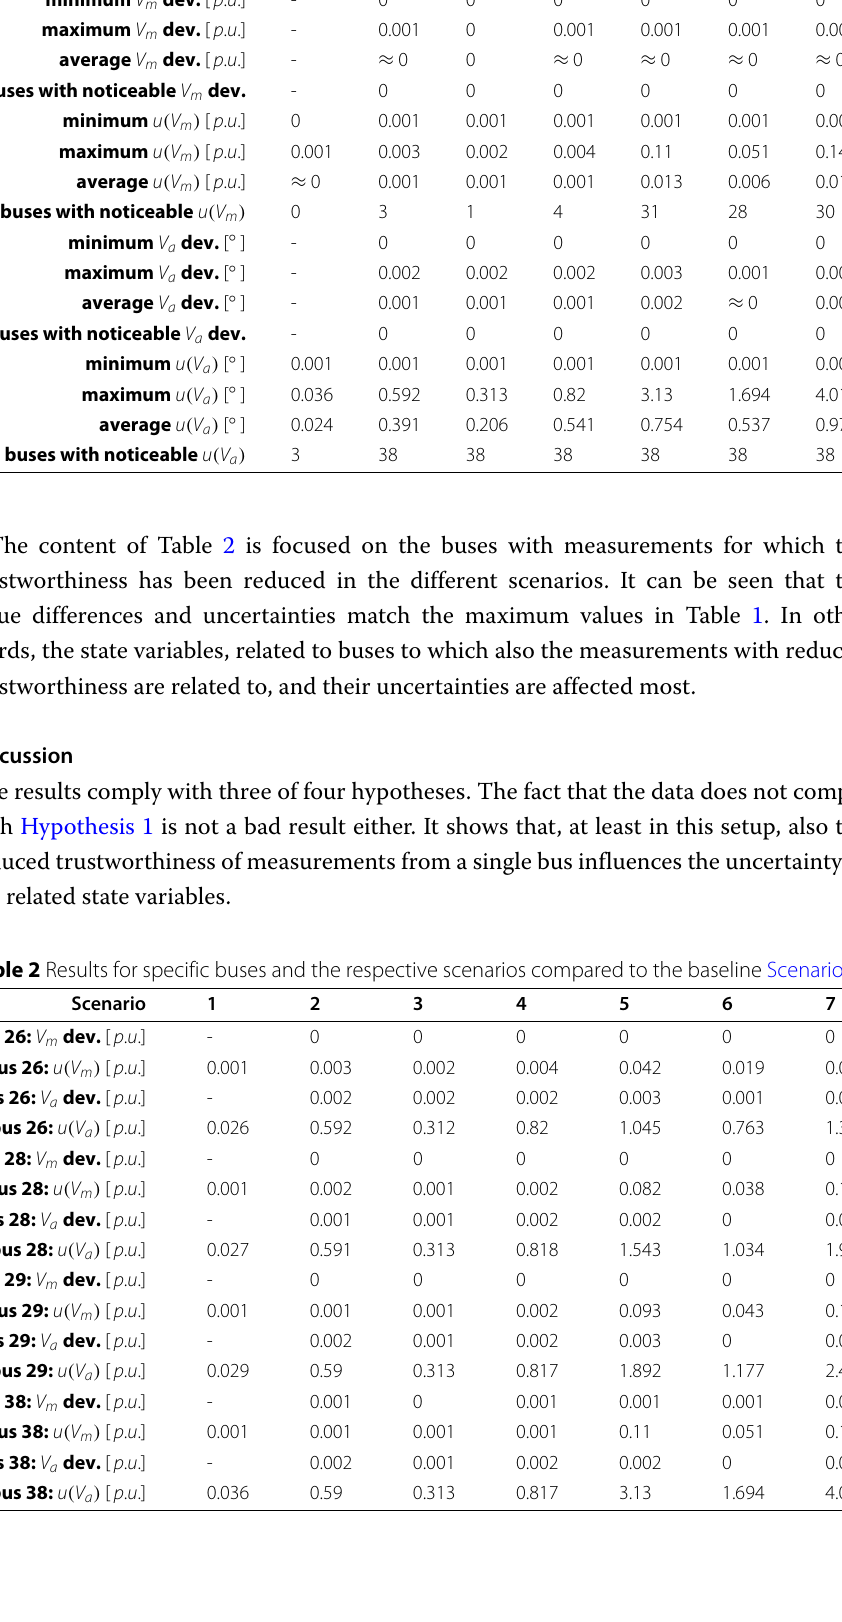
# buses with noticeable V m dev.